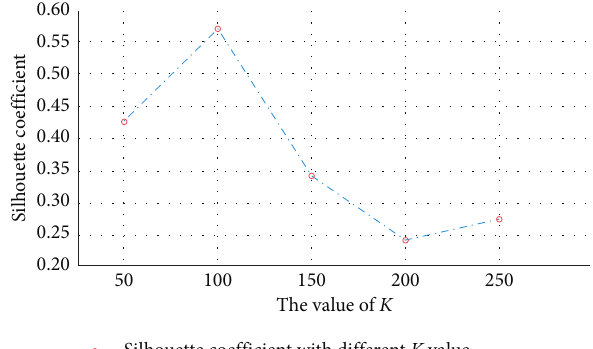
Figure 4: Clustering silhouette coefficient with different k